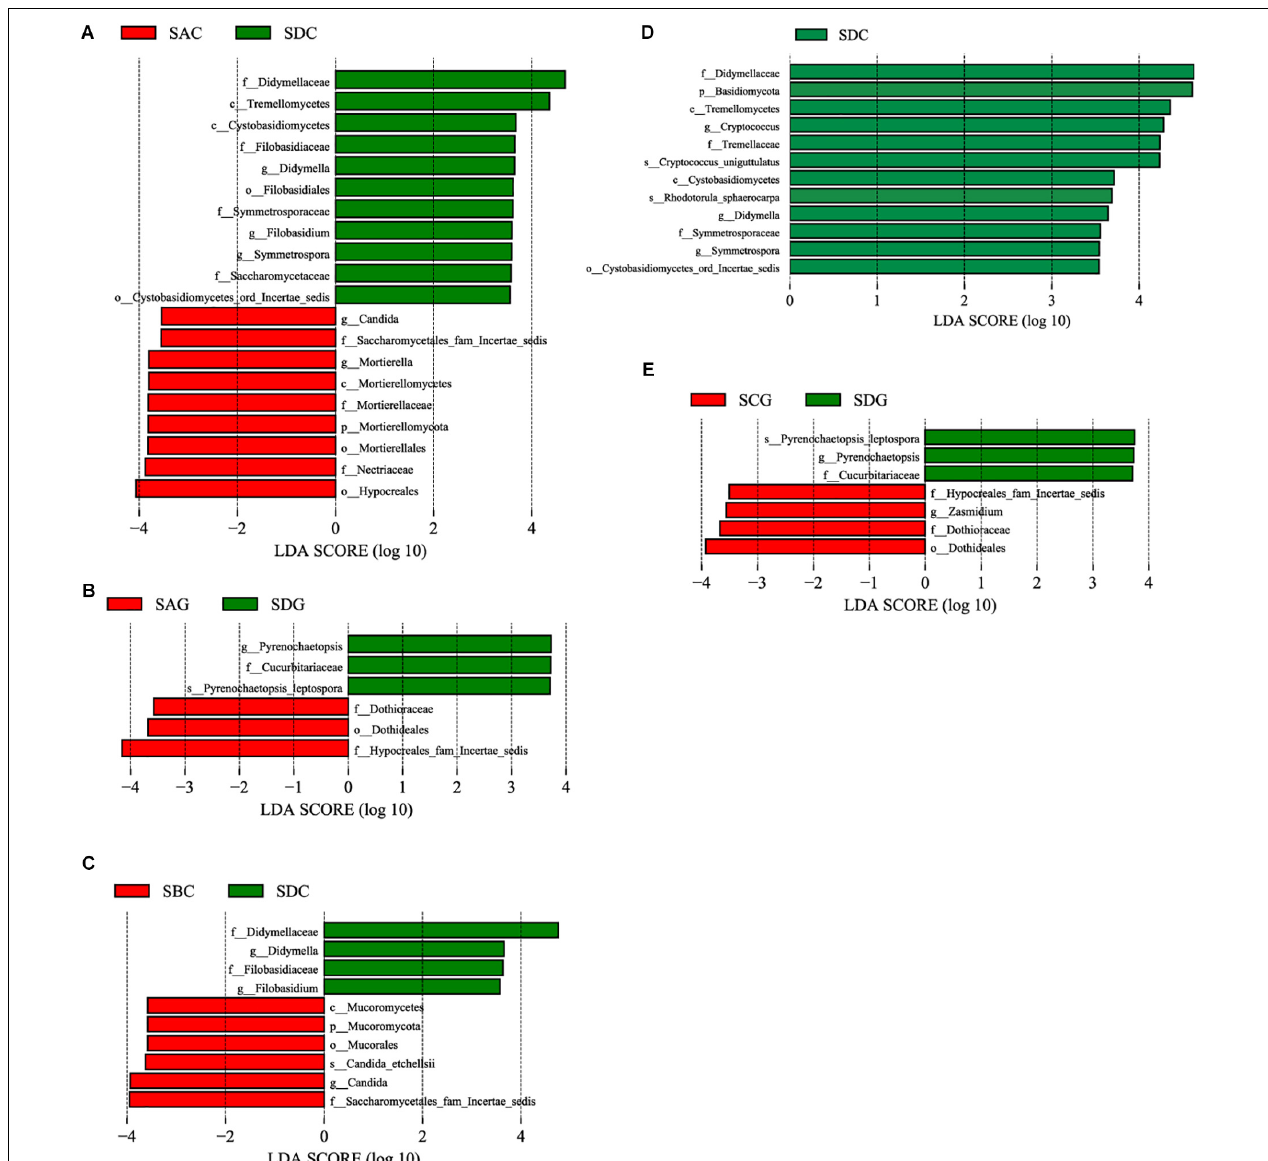
FIGURE 6 | Differences among diseased and healthy groups were determined by LEfSe. The highlighted taxa were significantly enriched in the group that corresponds to each color. LDA scores can be interpreted as the degree of difference in relative abundance. (A) Comparison between SAC and SDC; (B) comparison between SAG and SDG; (C) comparison between SBC and SDC; (D) comparison between SCC and SDC; (E) comparison between SCG and SDG. p_, phylum, c_class, o_order, f_, family, g_, genus and s_, species; WinterC, winter intestinal group; WinterG, winter